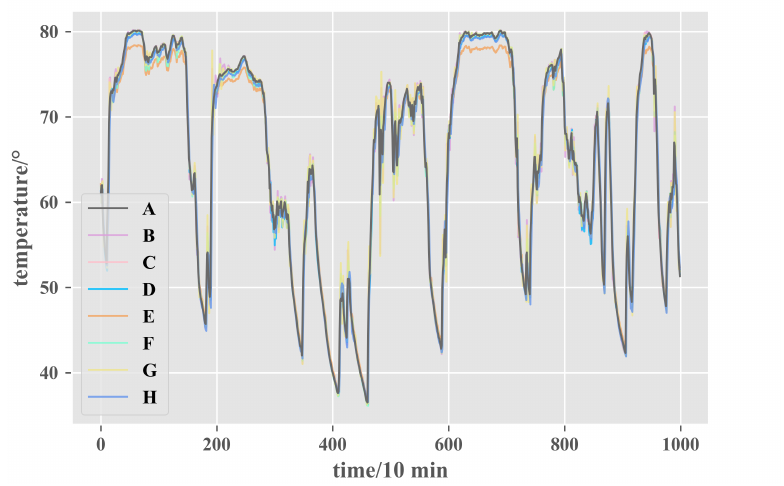
Figure 11. The comparison of different models for gearbox input shaft temperature prediction in #3.